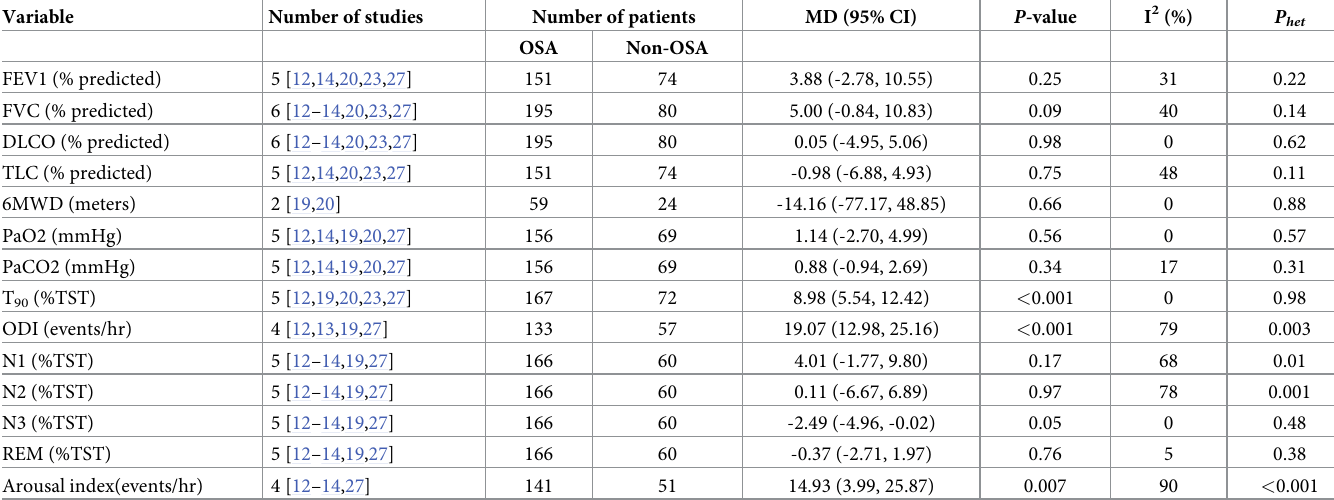
Table 3. Comparison of physiological and polysomnographic parameters between DPLD patients with and without OSA. Variable